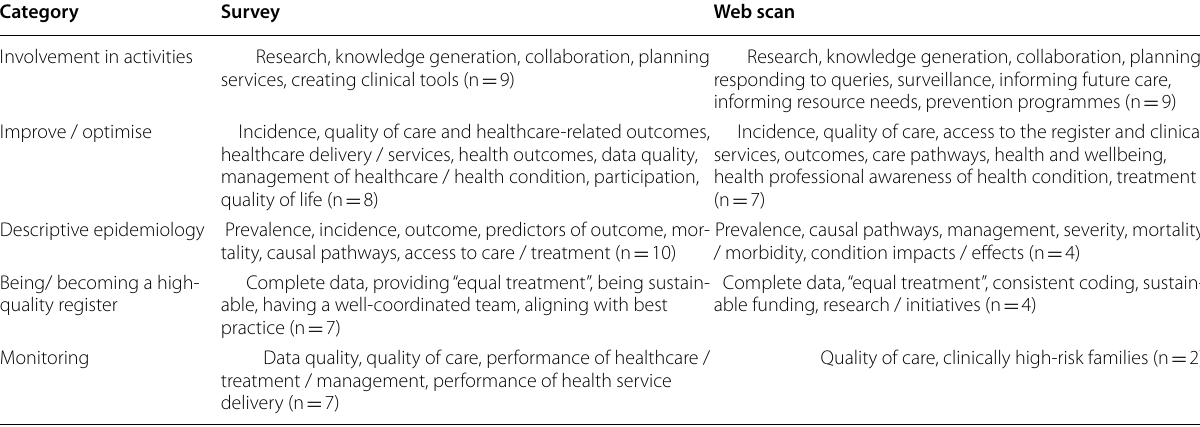
Table 1 Summary table of health register vision/aim categories from survey and web scan data